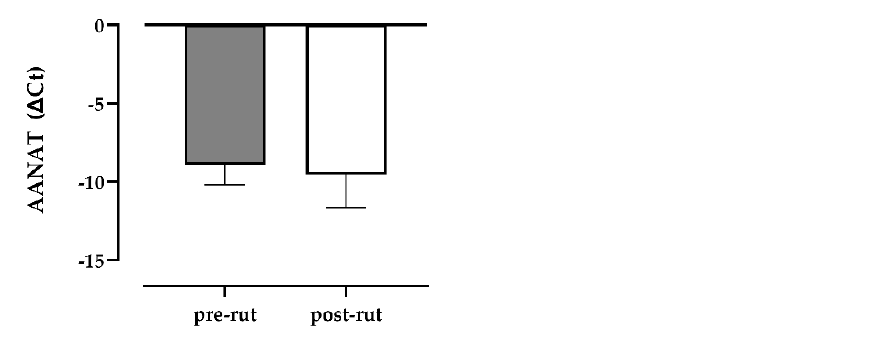
7 of 13 Figure 1. Differences between pre-and post-rut groups for the quantification of testicular paren- chymal melatonin ( A ) and DHEA ( B ). *, p < 0.05. DHEA, dehydroepiandrosterone. 3.2. qPCR for AANAT, ASMT, UCP1, MT1-2 The specificity of all PCR products was verified in relation to melting curve analysis